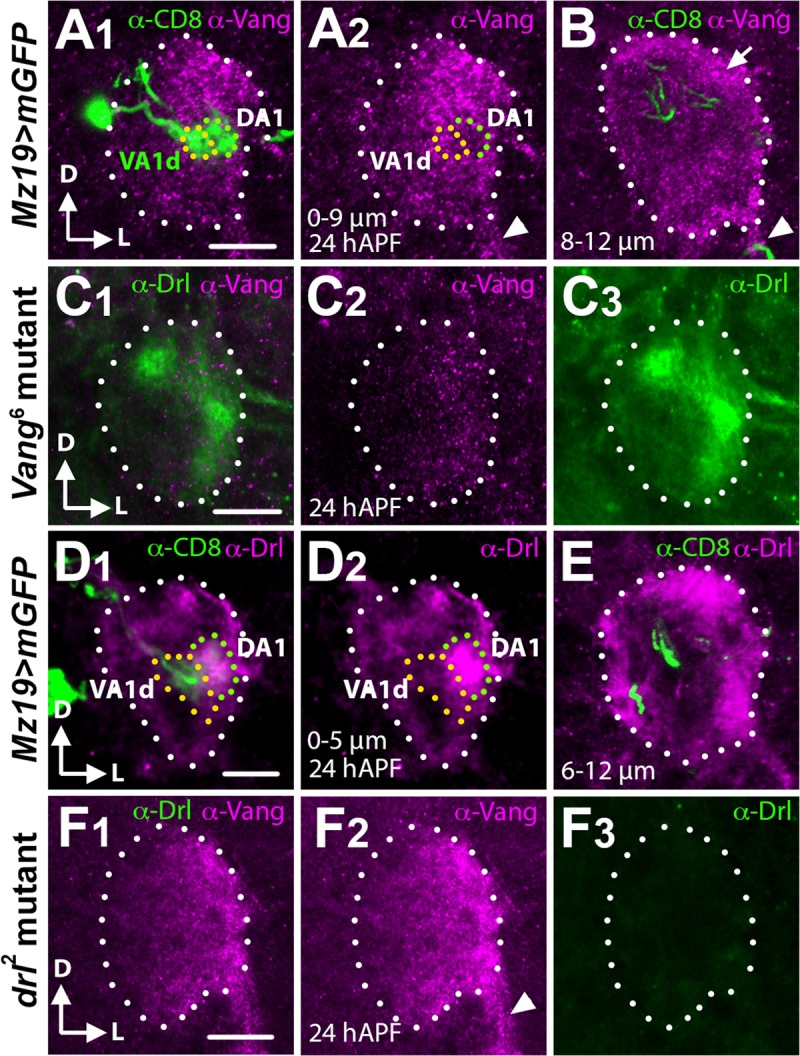
The Vang and Drl expression domains overlap with the developing DA1 and VA1d dendrites.Frontal views of 24 hAPF ALs stained with Vang and Drl antibodies. (A, B) An AL from animals expressing UAS-mCD8::GFP under the control of Mz19-Gal4 stained with antibodies against Vang (Magenta) and CD8 (green) to highlight the DA1 and VA1d PN dendritic arbors. Between 0–9 μm from the anterior AL surface Vang is found in puncta, which are highly concentrated in the AL dorsolateral region where the DA1 and VA1d dendrites are localized (A1, A2). In deeper sections (8–12 μm) Vang is observed in the nerve fiber layer (arrow) and the antennal nerve (arrowhead) (B). (C) An AL from Vang6 mutants stained with antibodies against Vang (Magenta) and Drl (green) (C1). The AL stained poorly for Vang (C2) but strongly for Drl (C3) attesting to the specificity of the Vang antibody. (D, E) An AL from animals expressing UAS-mCD8::GFP under the control of Mz19-Gal4 stained with antibodies against Drl (Magenta) and CD8 (green). From 0–5 μm the Drl protein is concentrated in the lateral AL where it co-localizes with the DA1 dendrites (D1, D2). The VA1d dendrites are located medially and express a low level of the Drl protein. Deeper down (5–12 μm) the Drl protein is found in the dorsal and ventrolateral neuropil structures (E). (F) An AL from drl2 mutants stained with antibodies against Vang (Magenta) and Drl (green) (F1). The AL stained strongly for Vang (F2) but not at all for Drl (F3) attesting to the specificity of the Drl antibody. Scale bars: 10 μm.